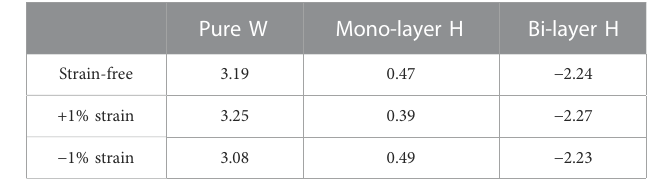
TABLE 1 The in fl uence of planar H clusters (i.e., mono-layer and bi-layer H clusters) on the formation energy (eV) of vacancy nearby in strain-free and strained W.